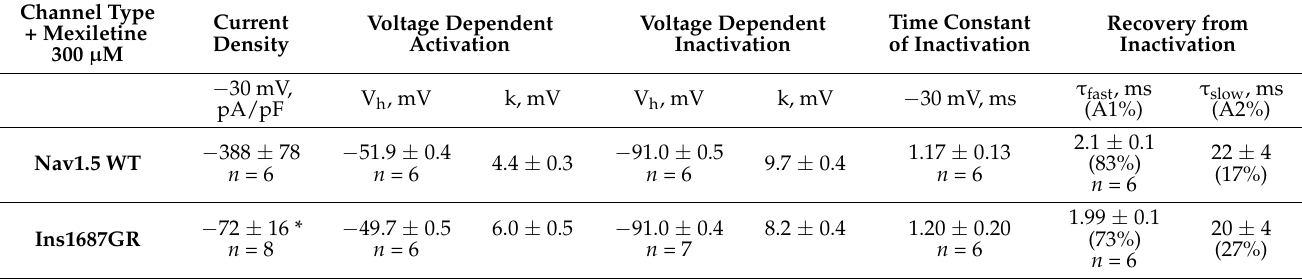
Figure 6. Biophysical properties of Nav1.5WT and WT+Ins1687GR channels expressed in HEK 293 cells. ( A ) Voltage-dependence of activation. ( B ) Voltage-dependence of fast inactivation. ( C ) Recovery from fast inactivation. Voltage protocols are indicated in the insets and detailed in the Supplementary Materials and Methods. ( D ) Bar graph showing window current measure for the indicated channels. The inset shows the triangular area under the overlapping point of the activation and inactivation curves of the respective channels. ( E ) Bar graph showing the amplitude of the sustained current measured at the end of a 100 ms pulse at − 30 mV for the indicated channels. Data are mean ± SE; n = 6 – 20 cells. Table 2. Current density and biophysical parameters of Nav1.5 WT and BrS mutant Ins1687GR channels expressed in HEK 293 cells after 24 h incubation with mexiletine 300 µ